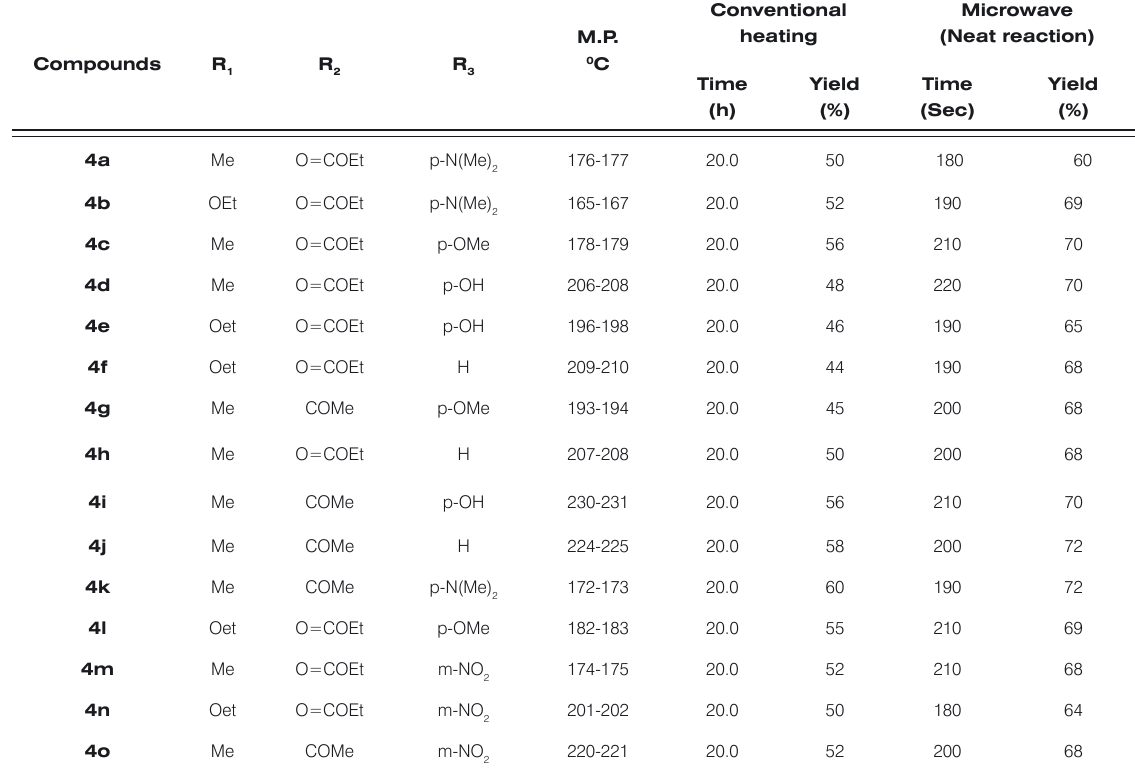
Table 1. Preparation of N-(6-methylbenzothiazolyl)-2,3,5,6-tetrasubstituted-4-(aryl)-1,4-